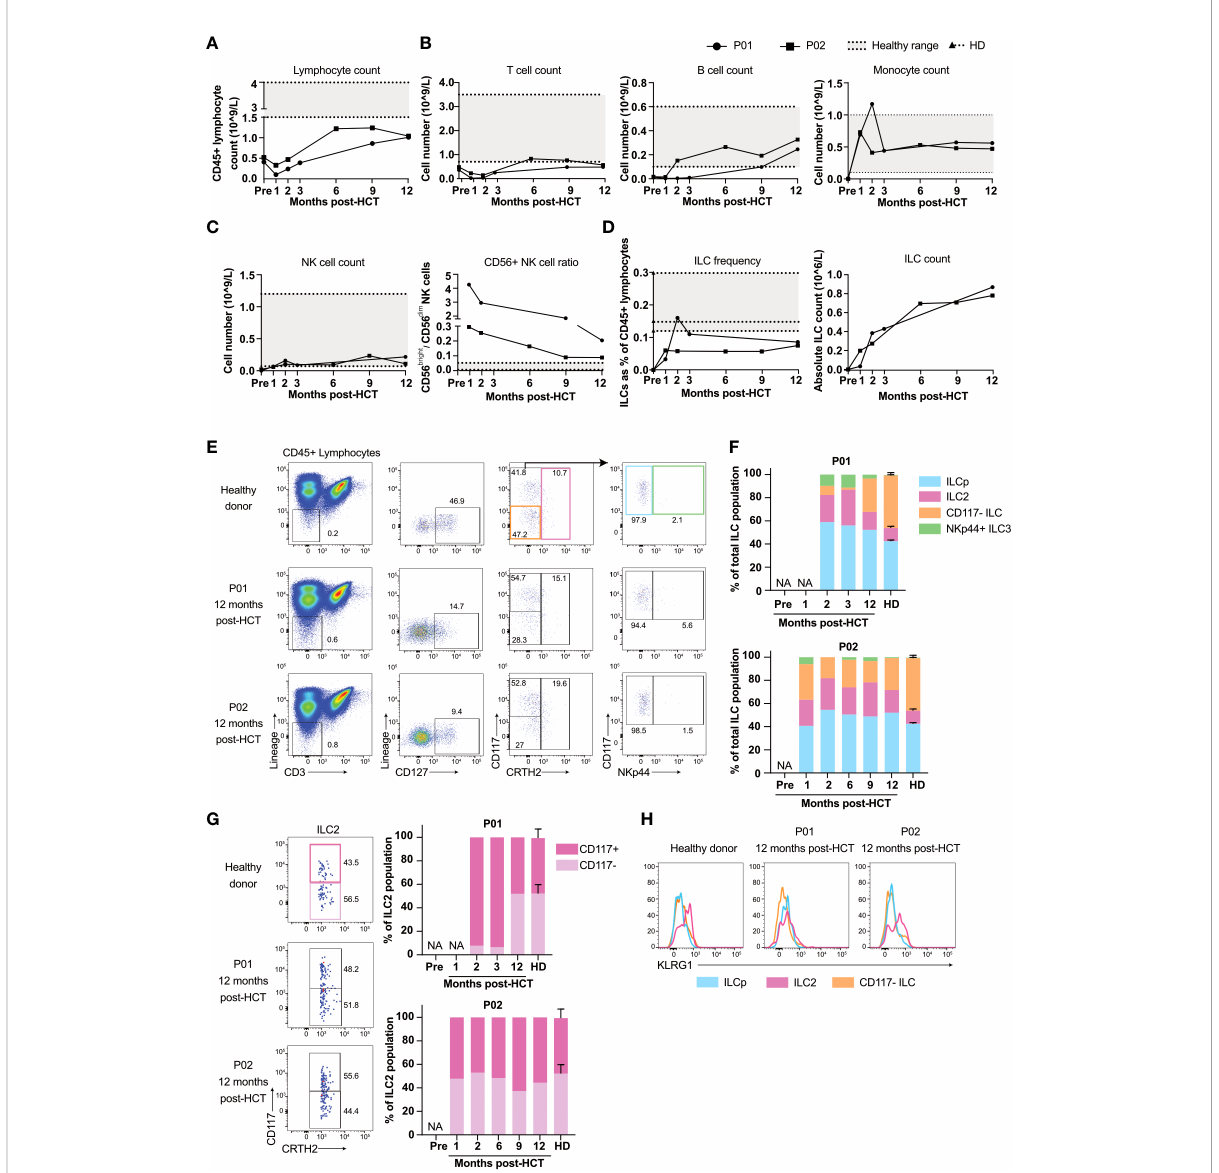
FIGURE 2 Reconstitution of T, B, NK cells and ILCs after allogeneic HCT. (A) Peripheral blood CD45+ lymphocyte number of P01 and P02 pre- transplantation and at consecutive timepoints post-transplantation. (B) Panels show the absolute count of peripheral blood T cells and B cells, in P01 and P02 calculated with the obtained frequencies from our fl ow cytometry data (Figure S1) and the absolute CD45+ lymphocyte numbers from (A) . Numbers of monocytes are obtained from the clinical lab. The grey area in the panels indicate the healthy range as employed by the clinical laboratory. (C) Panels show the absolute count of peripheral blood NK cells (left panel) calculated with the obtained frequencies from our fl ow cytometry data (Figure S1) and the absolute CD45+ lymphocyte numbers from (A) , and the ratio of CD56 dim CD16+ and CD56 bright CD16- (right panel). The dashed lines indicate the individual healthy donor (HD) values with the grey area showing the range of the HD values. (D) ILC frequencies in peripheral blood pre- and post-transplantation calculated as the percentage of viable CD45+ lymphocytes (upper panel) and absolute numbers (lower panel) of P01, P02 and 3 healthy donors (HD; dashed lines indicate the individual HD values with the grey area showing the range of the HD values). The absolute number of peripheral blood ILCs in P01 and P02 were calculated with the frequencies obtained from our fl ow cytometry data (Figure S2A – C) and the absolute CD45+ lymphocyte numbers from (A) . (E) Flow cytometric analysis of the cryopreserved PBMC from a healthy donor (representative for n=3) and P01 and P02 collected at 12 months post-transplantation. ILCs are selected as viable CD45+ Lin- CD3- CD127+ cells. CD117- ILC1s are gated for by selecting CD117- CRTH2- cells (orange gate), ILC2s are CRTH2+ (red gate) and CD117+CRTH2- cells (blue gate) can be subdivided into NKp44- ILCp or NKp44+ ILC3 (green gate). (F) Peripheral blood ILC subset frequencies within the CD127+ ILC population of healthy donors (N=3), P01 and P02. Samples were collected at indicated timepoints. NA = not applicable due to low cell numbers. (G) Quanti fi cation of CD117- and CD117+ ILC2s as a percentage of total CRTH2+ ILCs, gated for as in (E) . (H) Expression of KLRG1 on CD117- ILCs, ILCp and ILC2s, gated for as in (E)